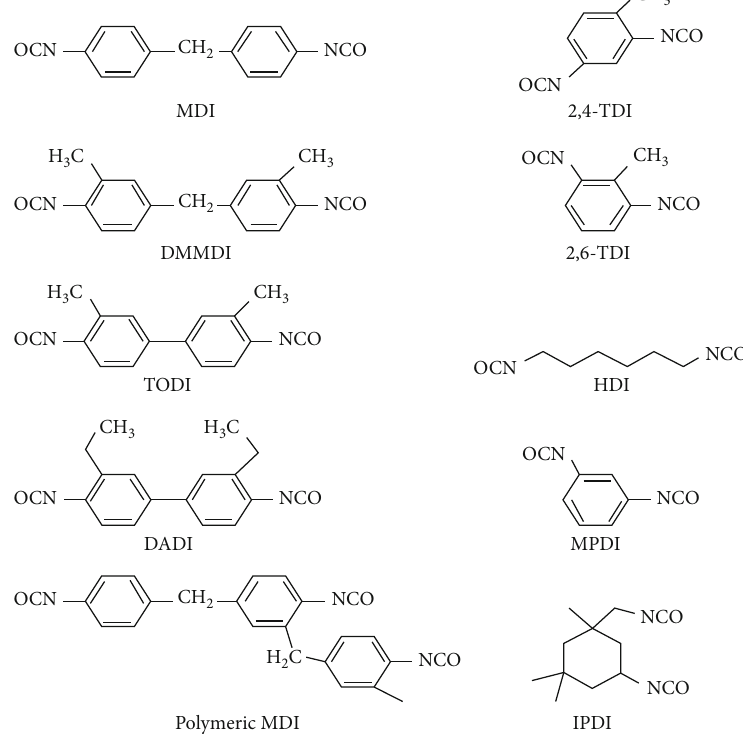
Figure 1: Overall fl